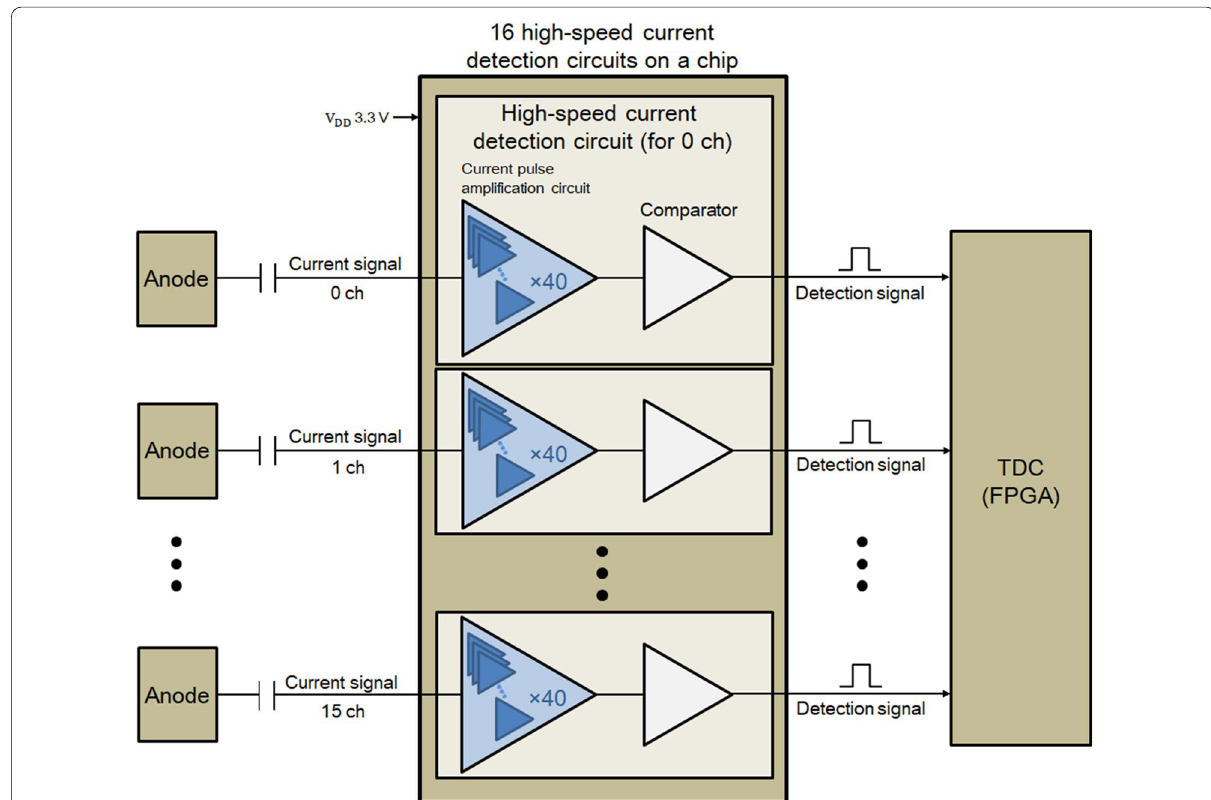
Fig. 3 Block diagram of high-speed current detection circuit. One channel of the high-speed current detection circuit consists of a current pulse amplification circuit and a comparator